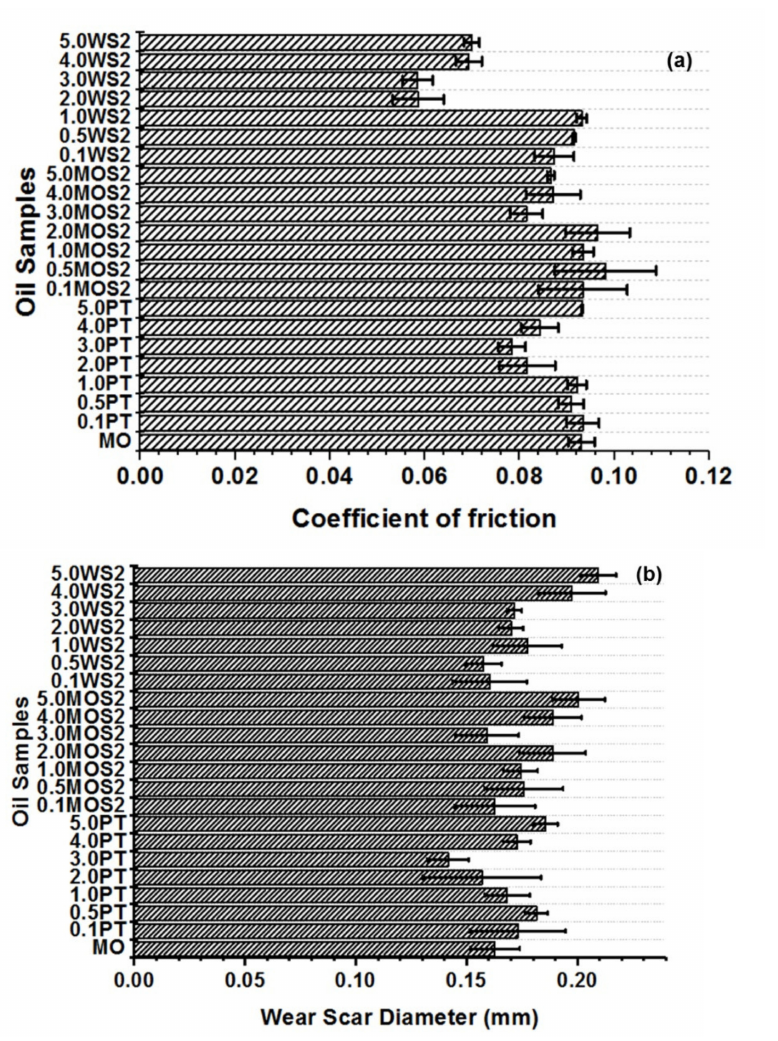
Figure 3. Anti-wear test results of oil samples. ( a ) Coefficient of friction; ( b ) Wear scar diame- ter (WSD).